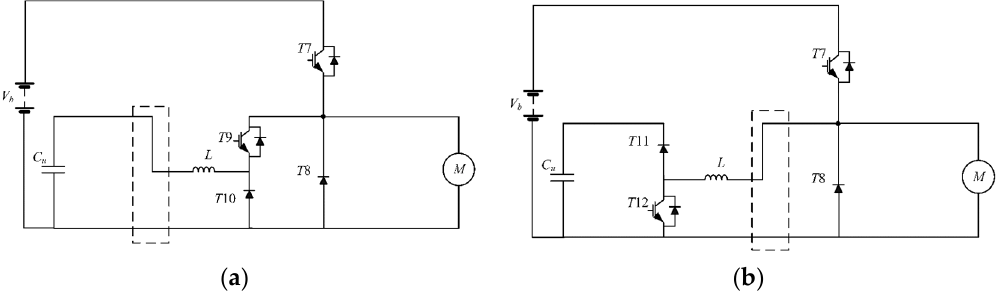
Figure 9. The charging process of the SC. ( a ) The buck mode. ( b ) The boost mode.